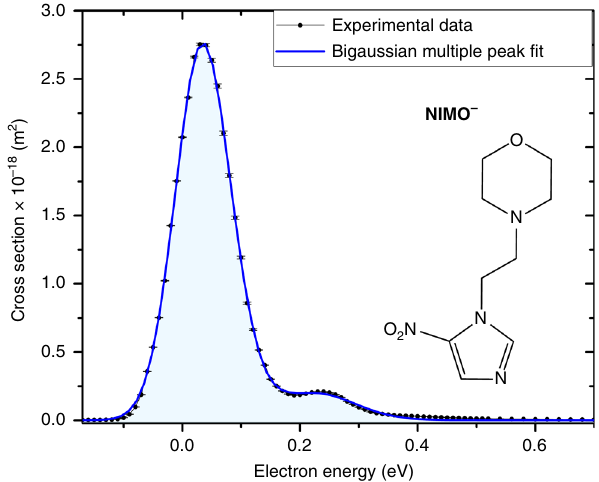
Fig. 1 Cross-section of the nimorazole radical anion and molecular composition. The black dots (connected by the black line as guide for the eye) represent the experimentally determined cross-section values as a function of the electron kinetic energy. Statistical error margins are included for each data point and refer to the standard error of the mean, see data analysis section for details. The blue line shows a bigaussian (sum of two Gauss peaks) multiple peak fi t of the experimental data. In addition,